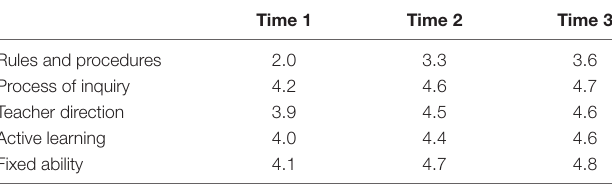
TABLE 4 | Grand mean composite scores for survey